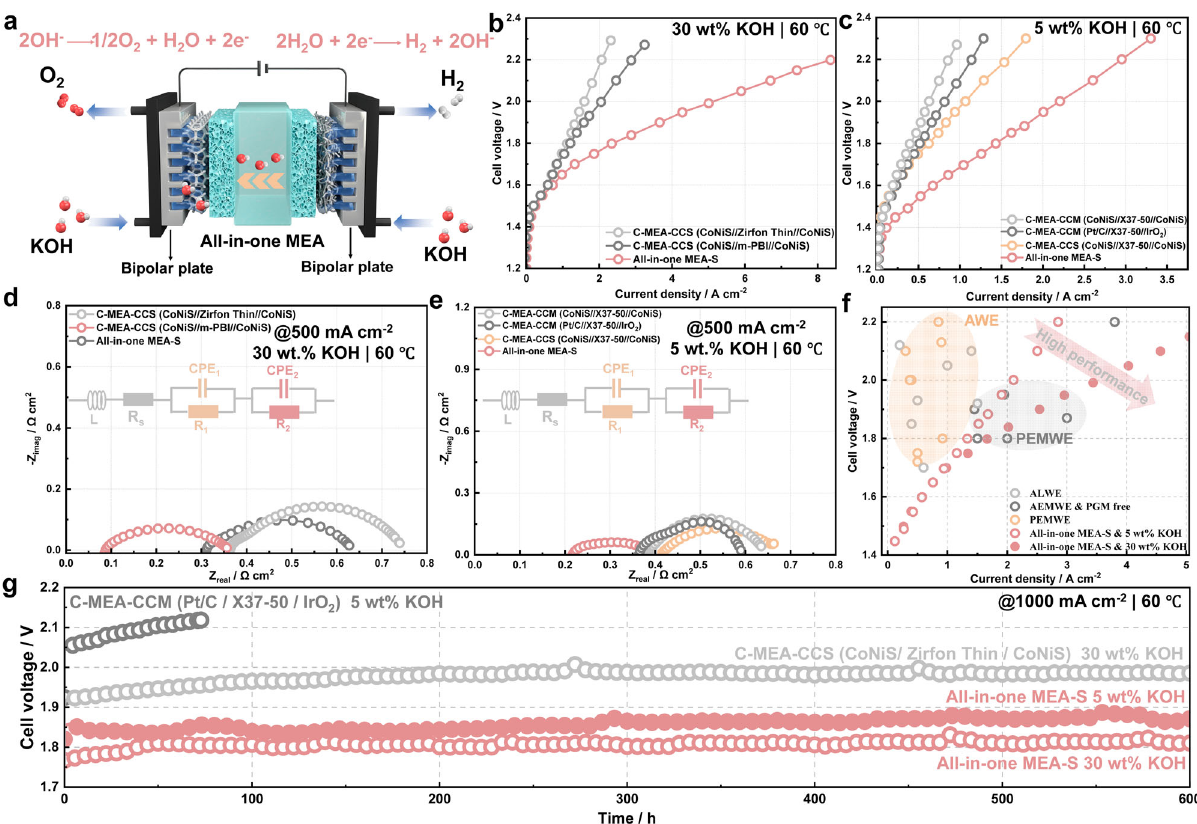
Fig. 4 | Electrolysis performance ofthe all-in-one MEAs. a Schematic diagram of advanced alkaline water electrolysisusing the all-in-one MEA.Carbonpaper and Ni foam were used asthe cathode and anodeliquid/gas diffusion layers, respectively. b Polarisation curves of the C-MEA-CCS (CoNiS//Zirfon Thin//CoNiS), C-MEA-CCS (CoNiS//m-PBI//CoNiS) and all-in-one MEA-S in 30wt% KOH at 60°C. The C-MEA- CCS (CoNiS//Zirfon Thin//CoNiS) and C-MEA-CCS (CoNiS//m-PBI//CoNiS) were prepared using self-supported CoNiS electrodes. c Polarisation curves of the C- MEA-CCM (CoNiS//X37-50//CoNiS), C-MEA-CCM (Pt/C//X37-50//IrO 2 ), C-MEA-CCS